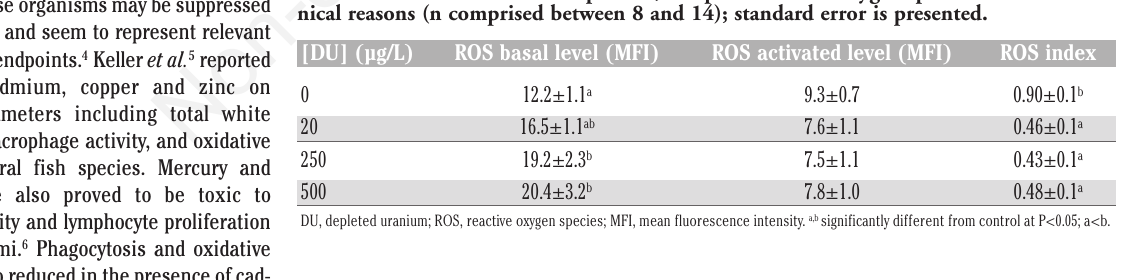
was higher in cells exposed to DU for all tested concentrations (Table 1). ROS stimulated level showed no difference between control and DU concentrations (Table 1). ROS stimulation index was therefore lower in cells exposed to